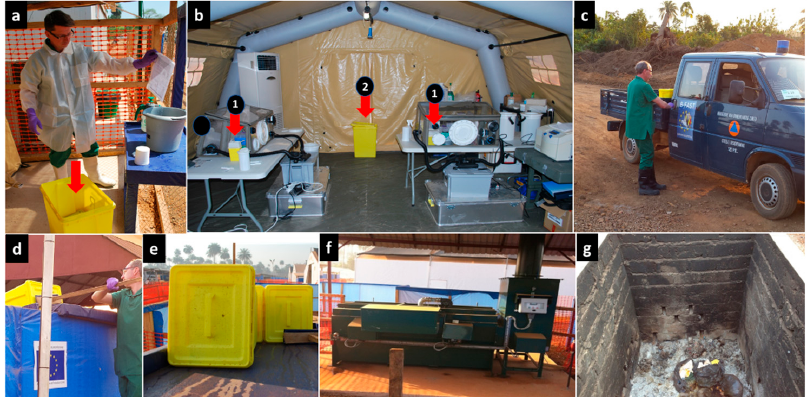
Figure 3. Illustration of the waste disposal route. It consisted of ( a ) waste management at the sample reception desk (Samples/Wastes window) outside the tent, ( b ) waste collection inside the laboratory tent, either in table top bin ( 1 ) or larger waste container ( 2 ) based on the activity and volume of the waste, ( c ) evacuation of waste by road to the incinerator, ( d,e ) delivery of waste containers over